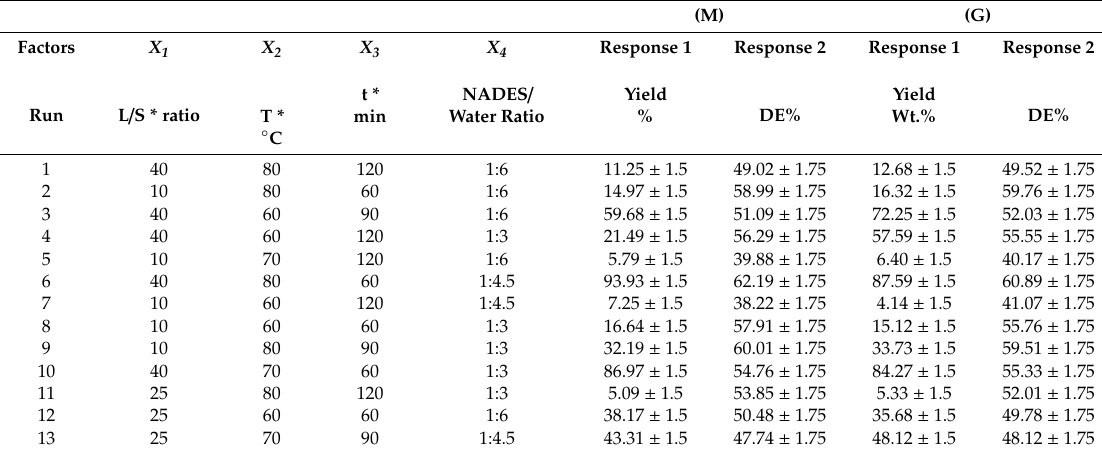
Table 3. Definitive screening design for the screening of four factors at three levels of pectin extraction using ChCl–malonic acid (M) and ChCl–glucose–water (G).